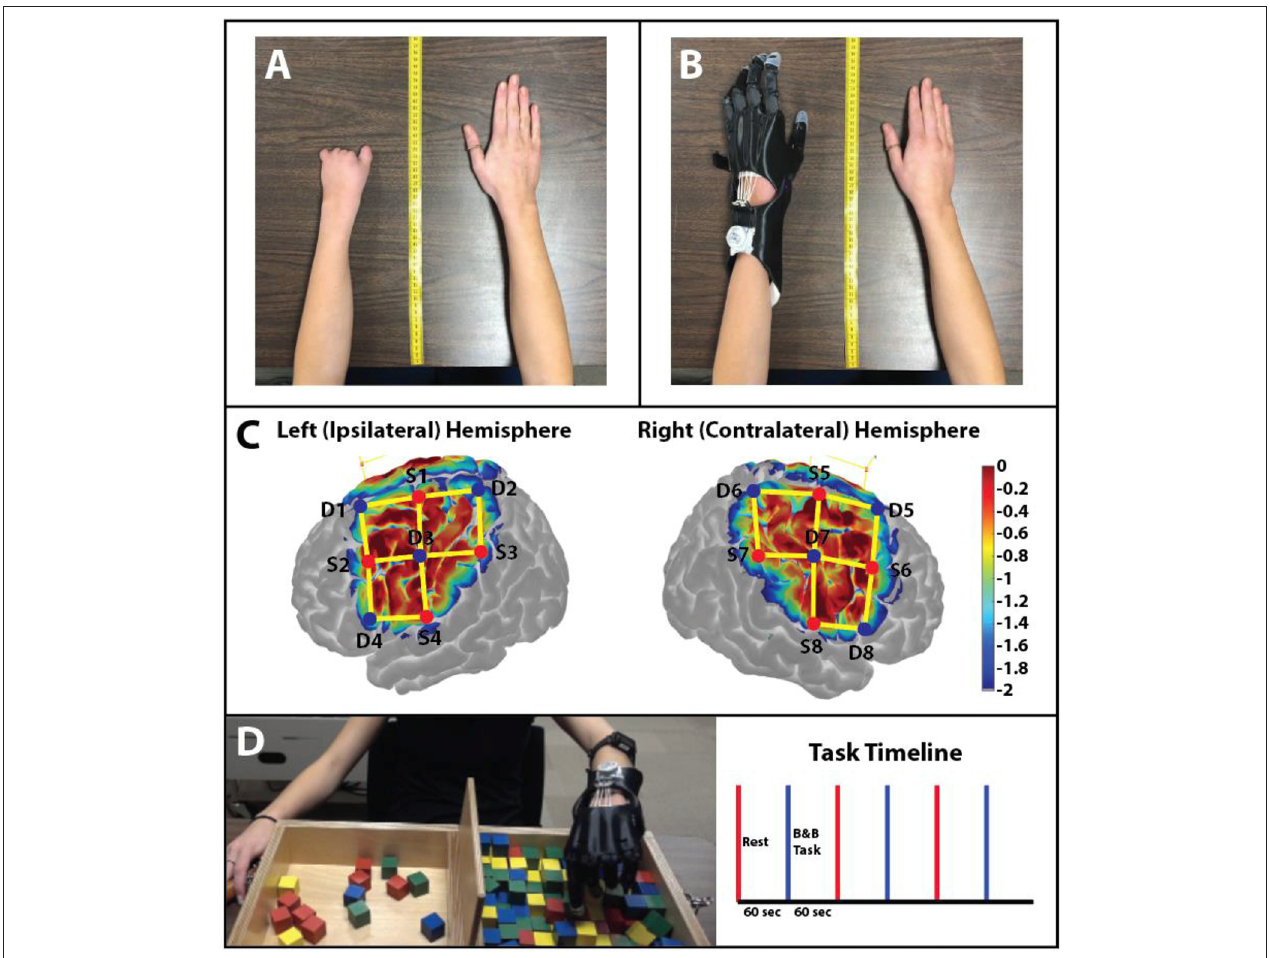
FIGURE 1 | Anthropomorphic measurement photos. (A) Photo of the participant’s non-affected (right) and affected (left) hand without the prosthetic hand. Measurements from the upper limbs were used to create a custom 3D printed prosthesis. (B) The 3D printed prosthetic hand used by the participant in this study. The prosthetic hand was modeled from the original design of the Cyborg Beast. (C) Sensitivity profile of the probe (Left and Right Hemispheres shown) used in this study. Log sensitivity index values closer to zero (red) reflect greater sensitivity for acquiring signals in that region (Aasted et al., 2015). Image created using AtlasViewer (v2.12.4). The location of the detectors (blue), the sources (red), and the channels (yellow lines) are shown for the subject. ( D) B&B Task: Protocol of the study: 60s of rest (red) followed by 60s of the B&B task (blue). A total of 3 trials were conducted for the affected hand.